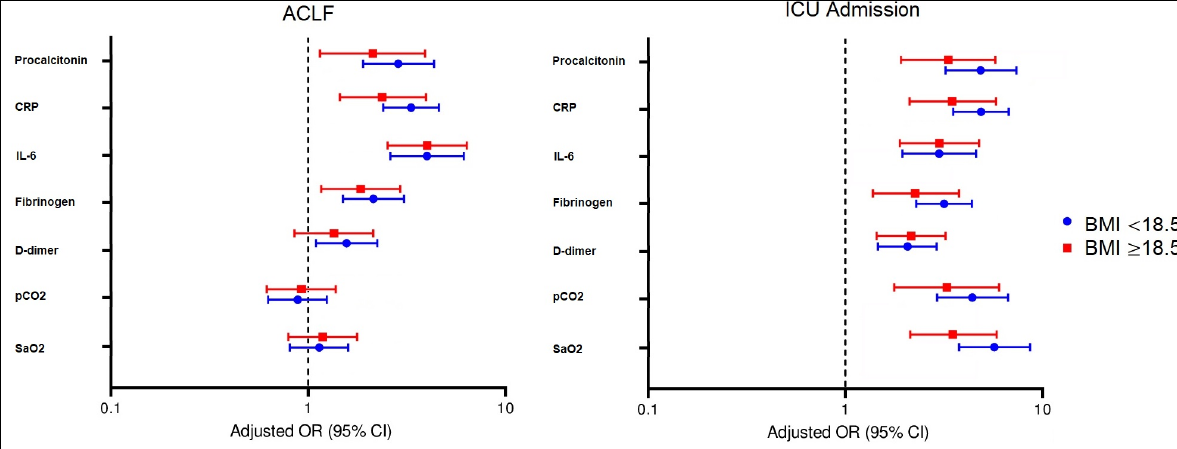
Figure 2. The association of inflammatory markers and arterial blood gases with ACLF and ICU admission in underweight and normal weighted patients with cirrhosis from the two study groups.